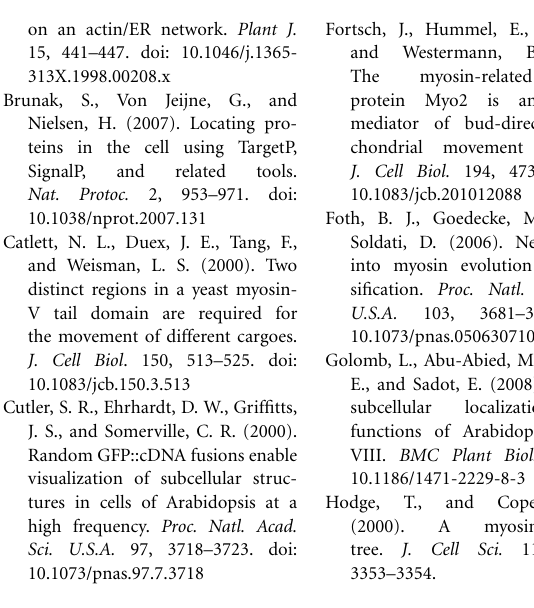
Table S1 | Predicted subcellular localization of A. thaliana class XI